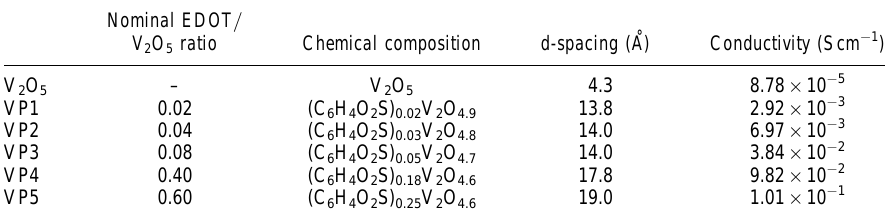
TABLE IV Nominal EDOT = V 2 O 5 Ratio, Chemical Compositions, d -spacing and Electrical Conductivity for the Pristine V 2 O 5 and